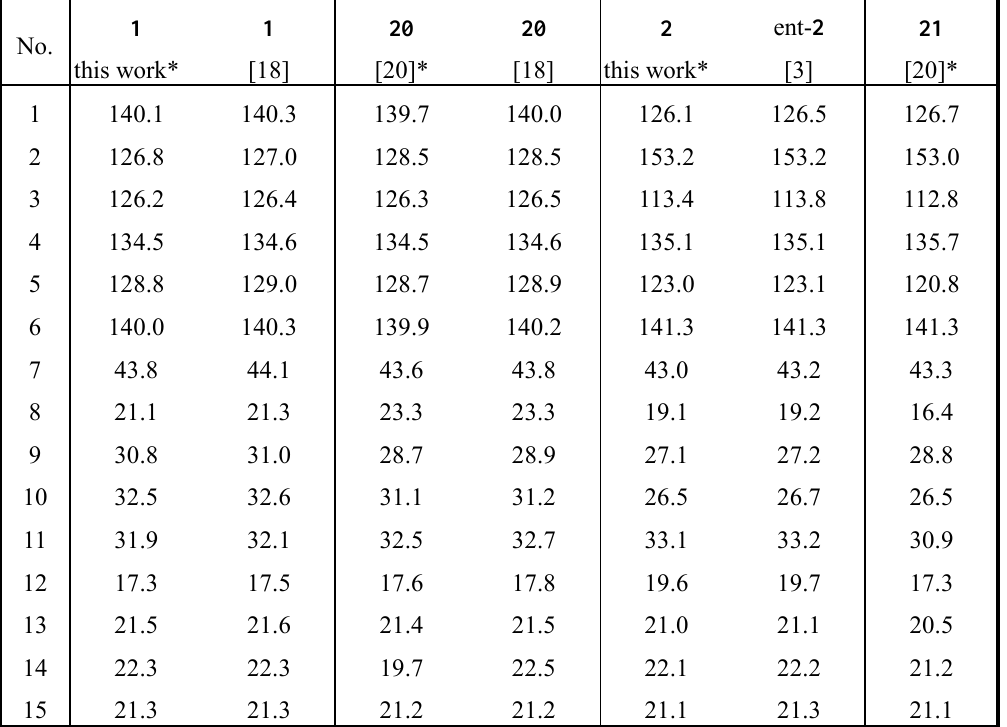
Table 2. 13 C-NMR data for the